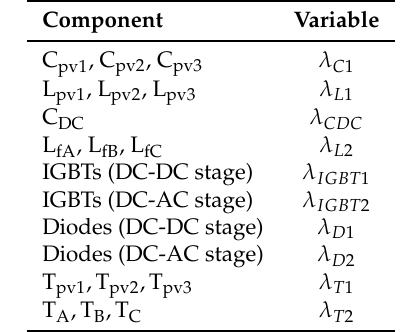
Table 3. Variables defining the failure rate per component.